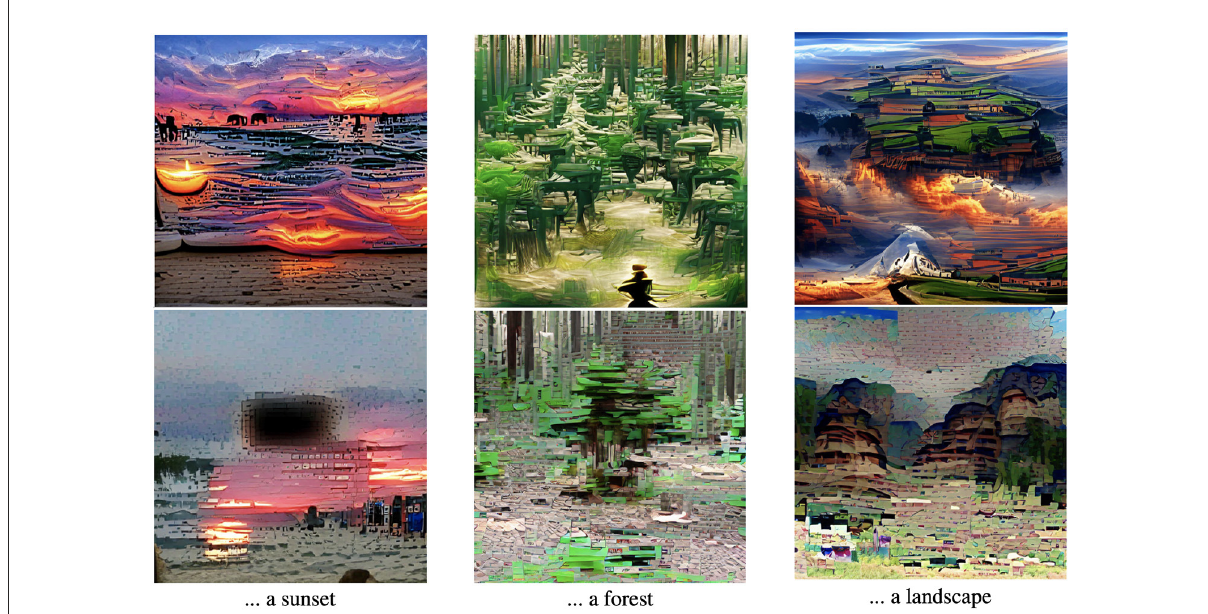
FIGURE4 Example images generated by CLIP (Radford et al., 2021) and VQ-GAN (Crowson, 2022; Esser et al., 2021). The top images use a prompt of the form “A outstanding picture of...” while the bottom images use prompts of the form “A horrible picture